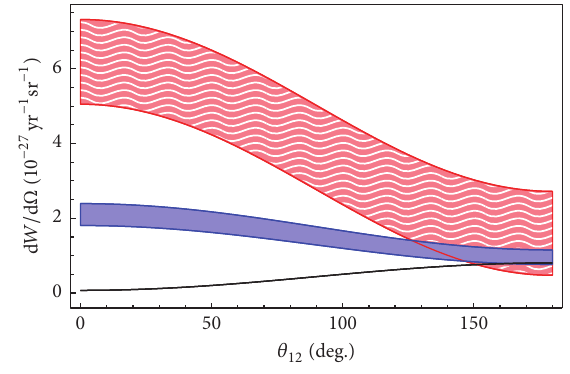
Figure 4: Same as Figure 2 for 136 Xe.